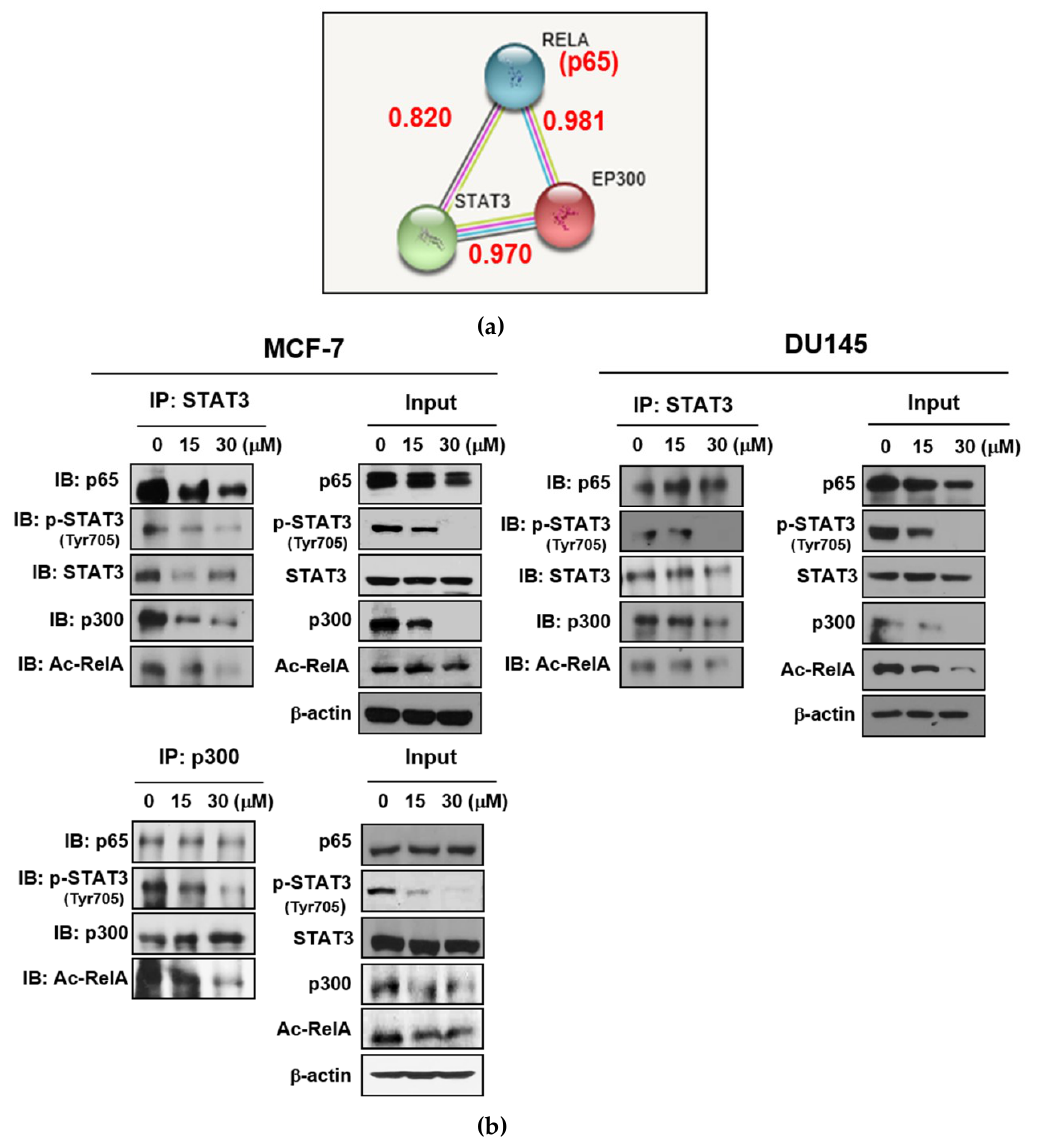
Figure 5 . Effect of LA on the interaction between p-STAT3, p300, and RelA in the MCF-7 and DU145 cells. ( a ) Protein–protein interaction (PPI) scores between STAT3, p300, and RelA/p65 by search tool for the retrieval of interacting genes / proteins (STRING) database. ( b ) MCF-7 and DU145 cells were treated with LA for 24 h. Immunoprecipitation (IP) was performed with cell lysates, using antibodies p300, and Ac-RelA in the whole cell lysates.